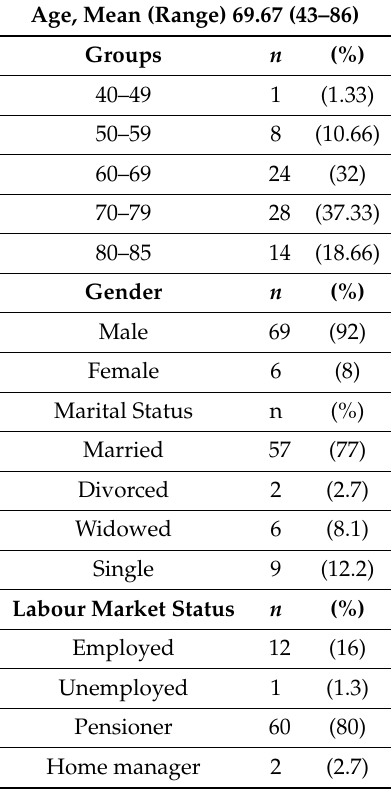
Table 1. Socio-demographic characteristics of COPD patients.